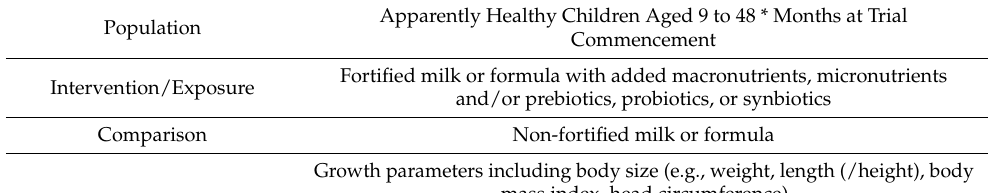
Table 1. Inclusion and exclusion